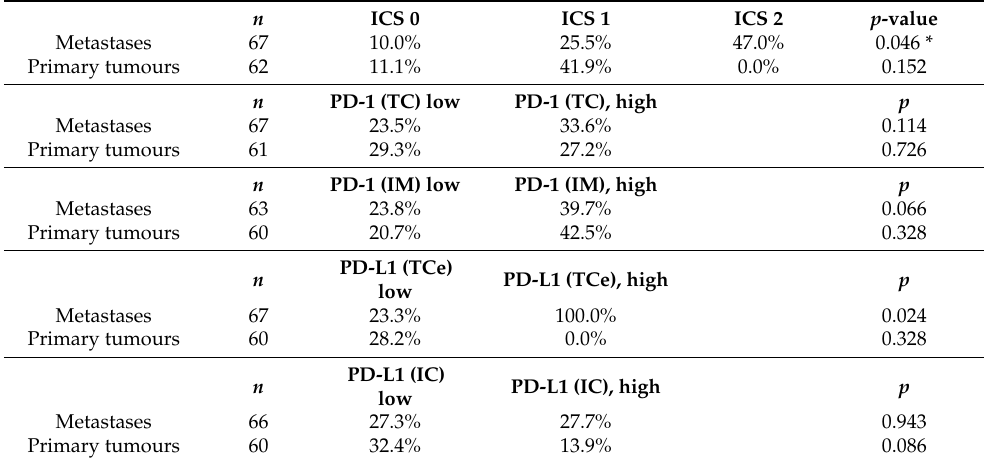
Table 2. 5-year survival rates in pulmonary metastases and 10-year survival rates in primary colorectal tumours stratified by ICS and PD-1 and PD-L1.